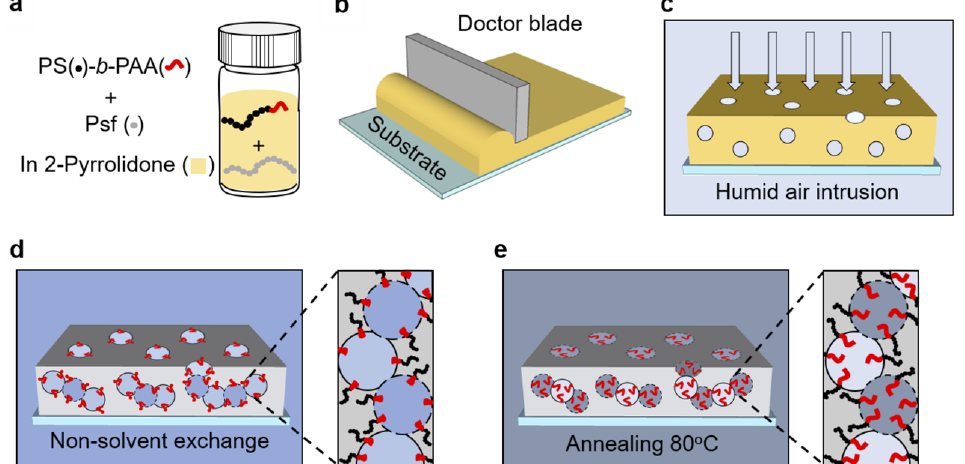
Figure 15. Schematic of the surface-segregation and vapor-induced phase separation (SVIPS) mem- brane fabrication process: ( a ) The polymer solution was prepared by dissolving the PSf and PS-b-PAA in 2-pyrrolidone. ( b ) The polymer solution was drawn into a uniform thin film on a glass substrate. ( c ) The casting solution thin film was exposed in a humid environment (with a relative humidity ∼ 95%) for a predetermined amount of time. The intrusion of water vapor from the humid air into the casting solution contributes to the formation of a uniform cross-sectional architecture comprised of spongy cells. ( d ) The film was subsequently plunged into a nonsolvent water bath that caused the hydrophobic polymers to precipitate and vitrify the membrane nanostructure. Simultaneously, due to their hydrophilic nature, the PAA brushes preferentially segregate toward the surface of the pore wall. ( e ) The composite membrane was annealed in a bath of DI water at 80 ◦ C to allow the PAA brushes to extend toward the center of the pore. Reproduced from [168], used under CC-BY 4.0. Then, the pore wall was chemically functionalized to attach binding sites for